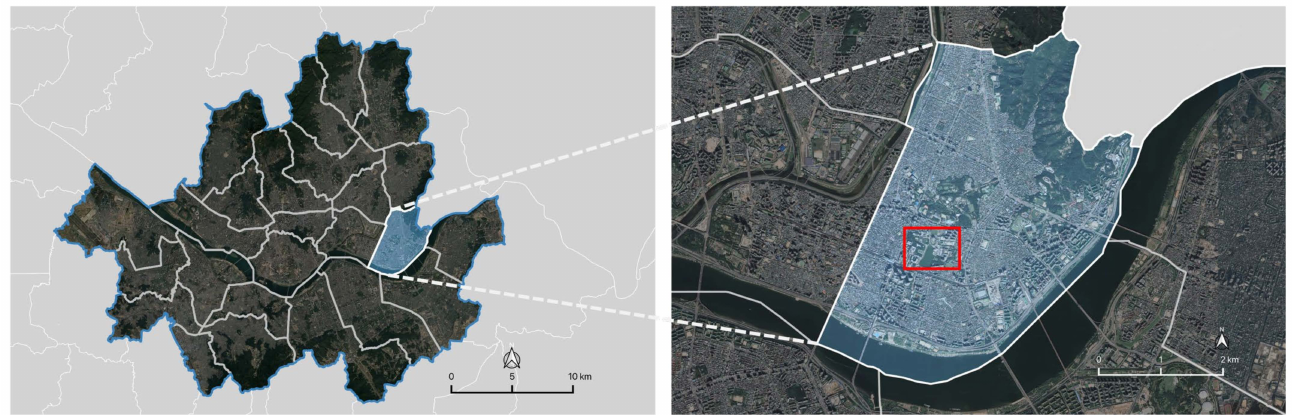
Figure 1. Study site locations (Gwangjin-gu, Seoul, South Korea). The site area is marked with a red box (473,565 m 2